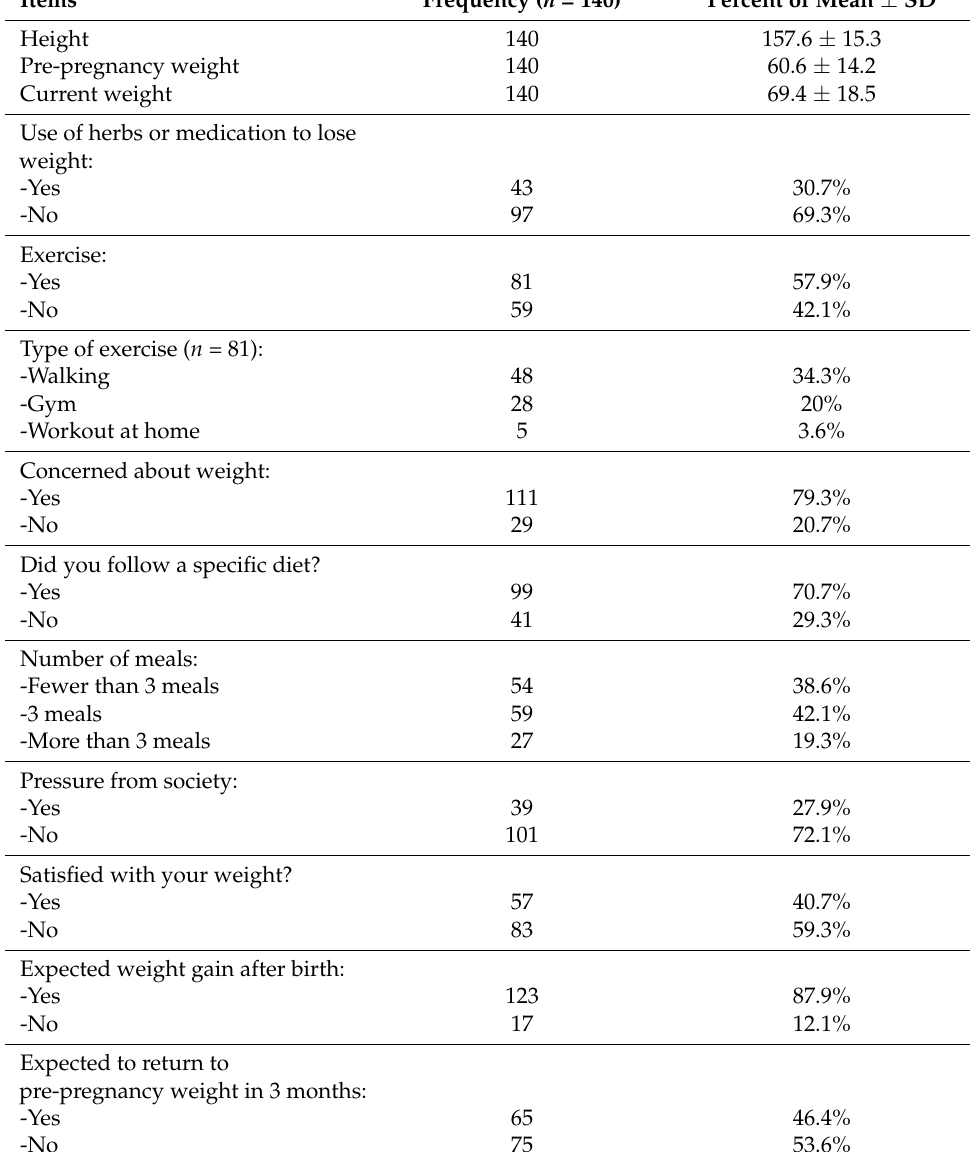
Table 4. Data related to postpartum weight retention among the study